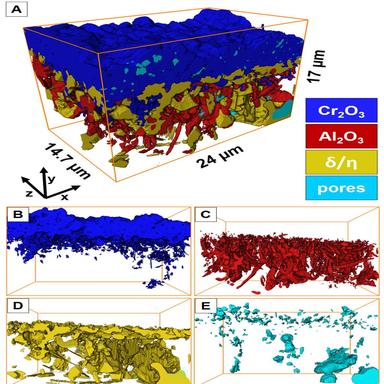
(A) 3D visualization of the microstructure of the oxide scale formed on the 718Plus superalloy after 1000 h of oxidation in dry air at 850 °C, rendered via tomographic reconstruction; (B–E) Microstructural features of individual components: B) Cr2O3, C) Al2O3, D) δ and η phases, E) pores.